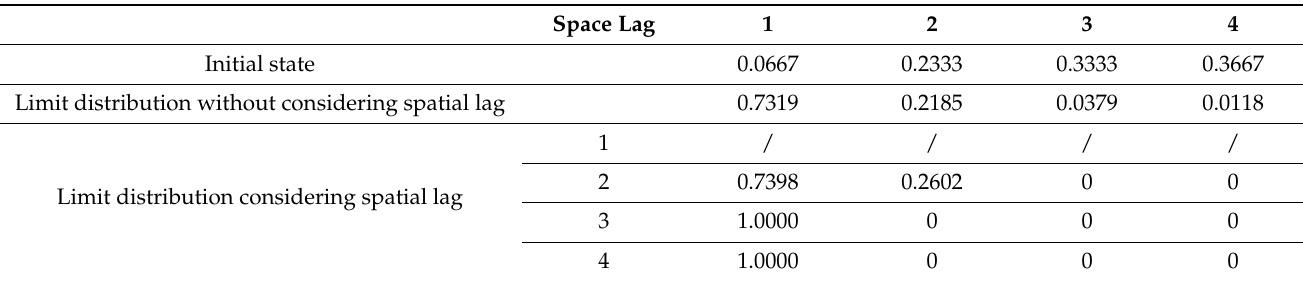
Table 4. Evolutionary trend prediction of ecological well-being performance type transfer in China. Space Lag 1 2 3